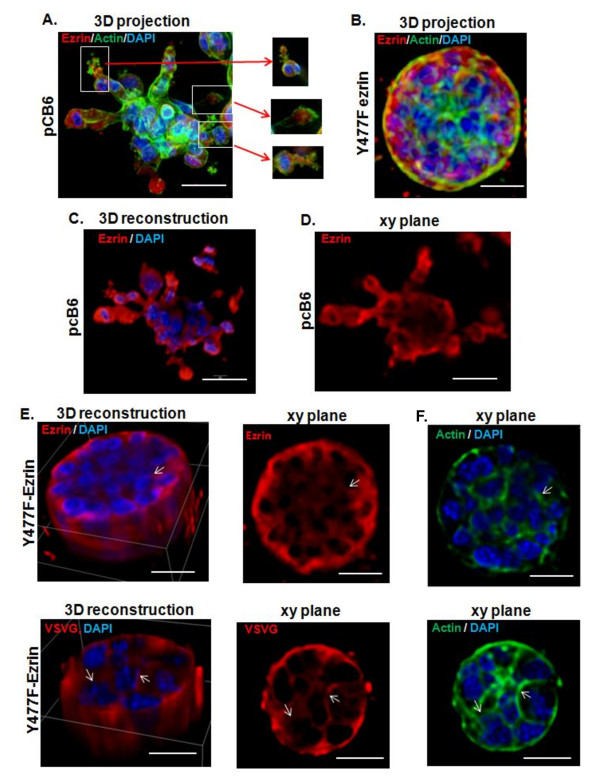
Cellular localization of ezrin and Y477F ezrin (VSVG tagged) in colonies growing in 3D Matrigel culture: Colonies formed from AC2M2 cells expressing pCB6 control vector or Y477F ezrin (clone C13) in day 12 embedded Matrigel cultures (see Figure 2) were fixed, and stained for ezrin (red), actin (green, phalloidin), and nuclei (blue, DAPI). Images of stained colonies were acquired using a Quorum Wave FX spinning disk confocal microscope. Panels A & B) 3D projection images of pCB6 control and Y477F ezrin expressing clones are shown (three colours merged). Inserts show single XY plane of actin-rich cellular protrusions with ezrin localized to the cytoplasmic side in pCB6 colonies. No actin-rich protrusions were evident in Y477F ezrin colonies. Panel C) Images of pCB6 colonies were deconvoluted and subjected to 3D reconstruction using Metamorph software. A middle section showed strong localization of ezrin in cellular extensions, compared to weak expression in the central core of colonies. Panel D) A middle xy plane of the pCB6 colony shown in C confirmed the absence of a hollow lumen. Panel E) Deconvoluted images of Y477F ezrin expressing colonies stained for ezrin or VSVG were subjected to 3D reconstruction as above. A middle xy plane showed a partial membranous staining which was strongest in the outer surface of colonies of Y477F ezrin-expressing cells, though some diffuse cytoplasmic staining was also evident. No hollow lumens were present. Panel F) XY planes corresponding to ezrin and VSVG staining in E show actin structures associated with the plasma membrane particularly at cell junctions. Images are representative of at least 20 colonies examined in each group. Scale bar indicates 50 μm.